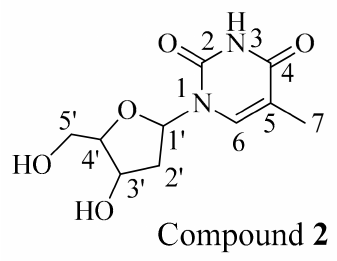
Figure 2. Chemical structure of compound 2 ,